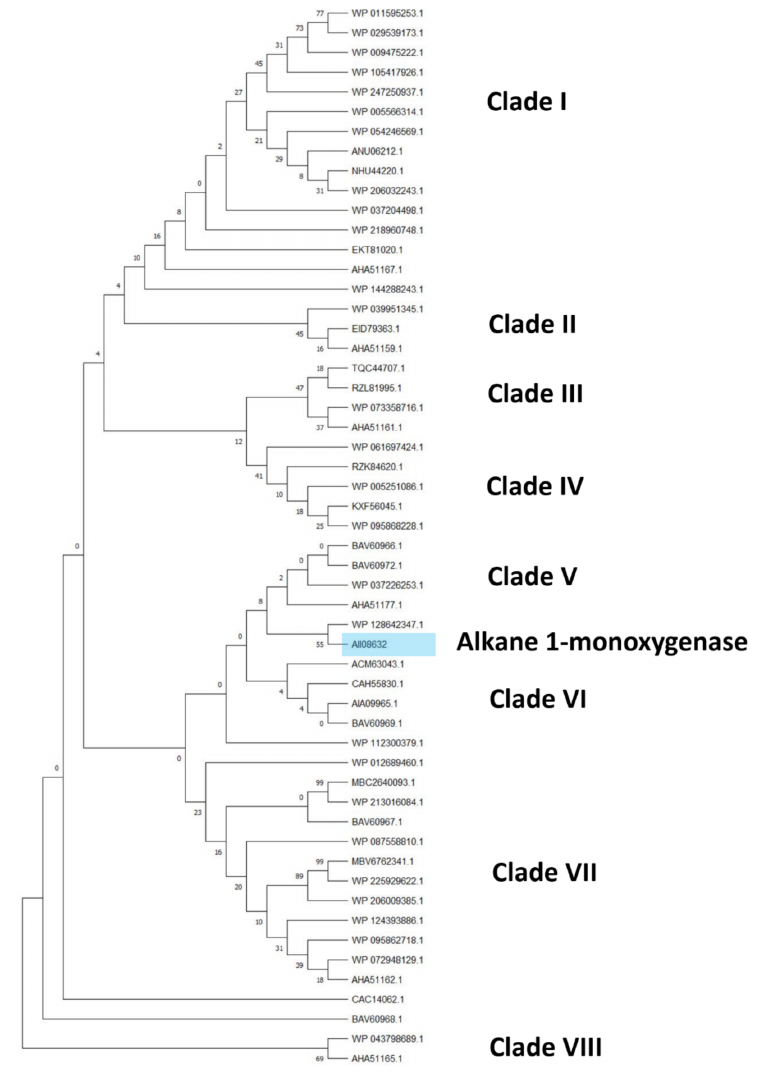
Figure 8. Subtree clusterization of HIT sequences identified by alkane monooxygenase input genes putatively involved in C-C backbone plastic degradation. Marked box evidences the reference input